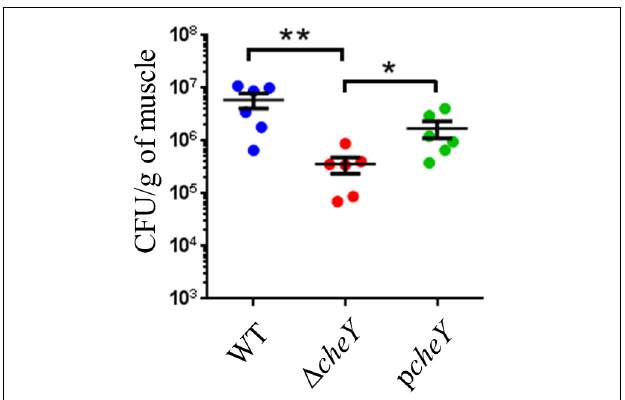
FIGURE 6 | Bacterial burdens calculated as CFU/g in the muscle tissue of mice ( n = 6/group) s.c.-inoculated with WT, (cid:49) cheY , and p cheY at 6 h post-infection. Error bars indicate SEM. ∗ P < 0.05, ∗∗ P < 0.01; Mann-Whitney U